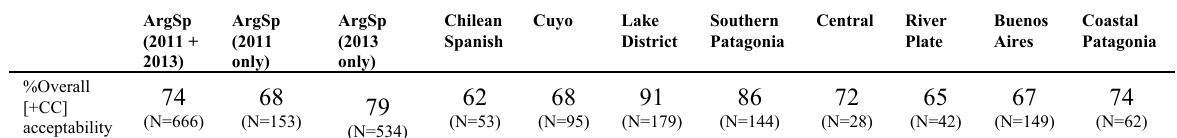
Table 8 . Overall percentage of CC acceptability per variety including Chilean